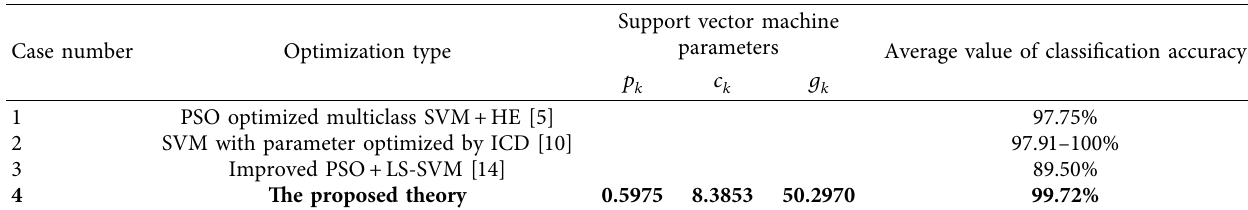
Table 9: Accuracy of bearing fault recognition.